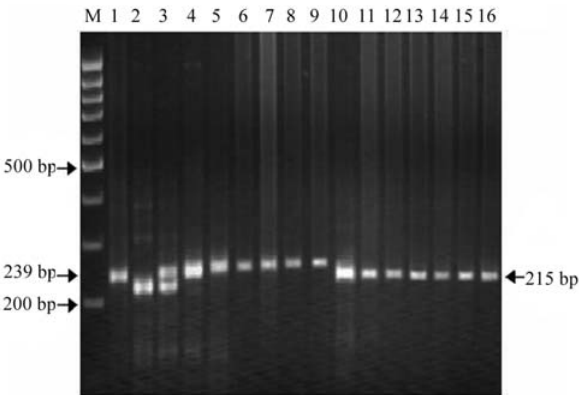
Figure3 -SelectivegenotypingofRILs(representingextremegroups)for spot blotch resistance in barley using BMS 32 SSRs primer; Lane M = 100-bp ladder marker; 1 = Resistant parent (IBON18); 2 = Suscepti- ble parent (RD2508); 3-9 = RILs with low disease severity; 10-16 = RILs with high disease severity.